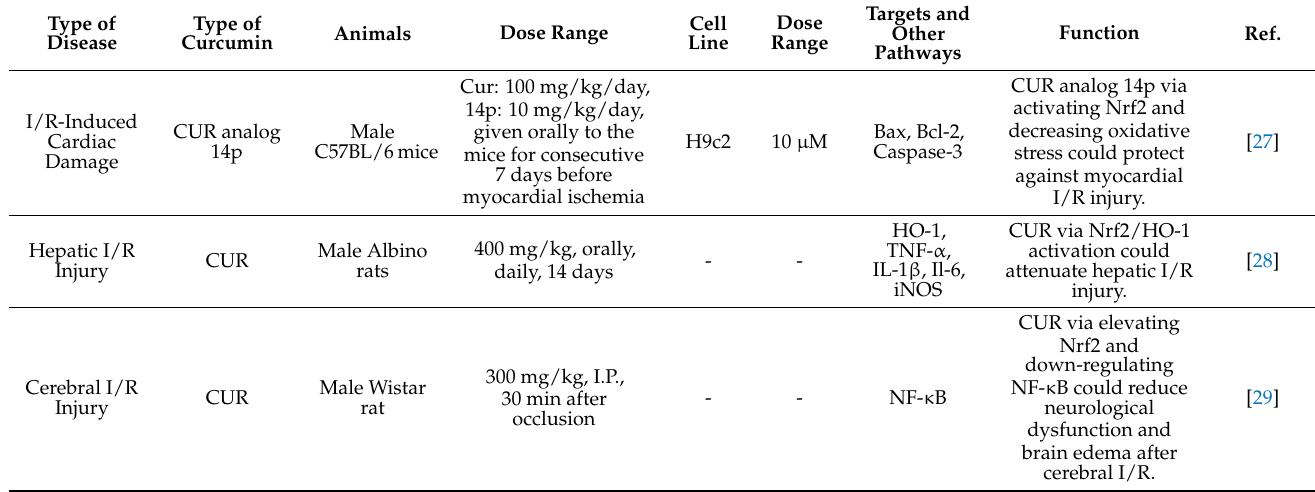
Table 2. Nrf2-related therapeutic effects of curcumin in ischemia-reperfusion (IR)